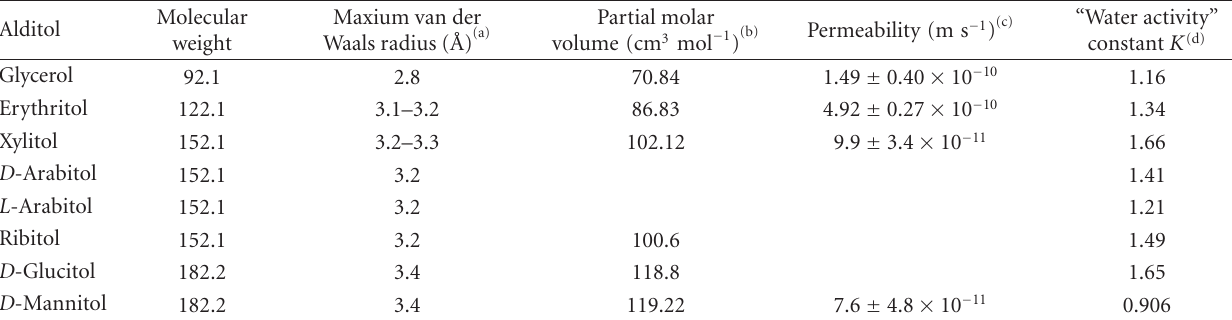
Table 3: Physicochemical properties of alditols at 25 ◦ C.